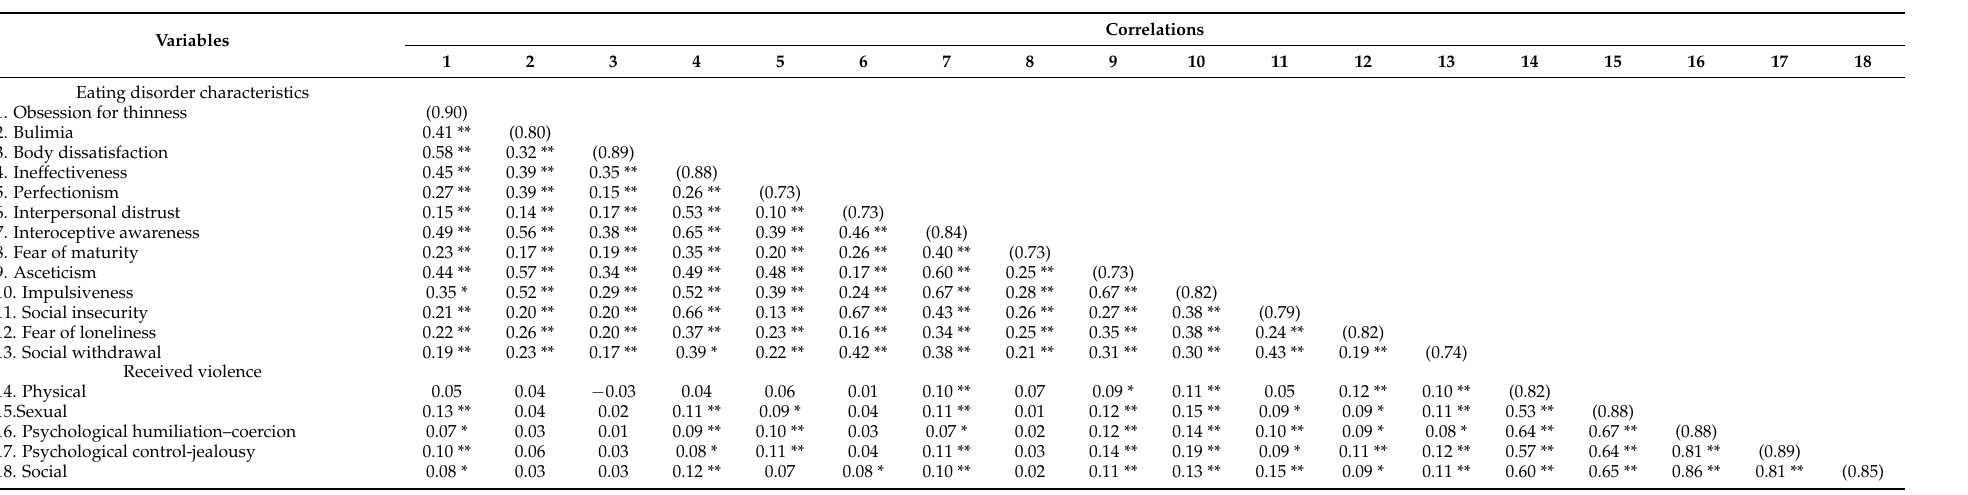
Table 2. Bivariate correlations between the study